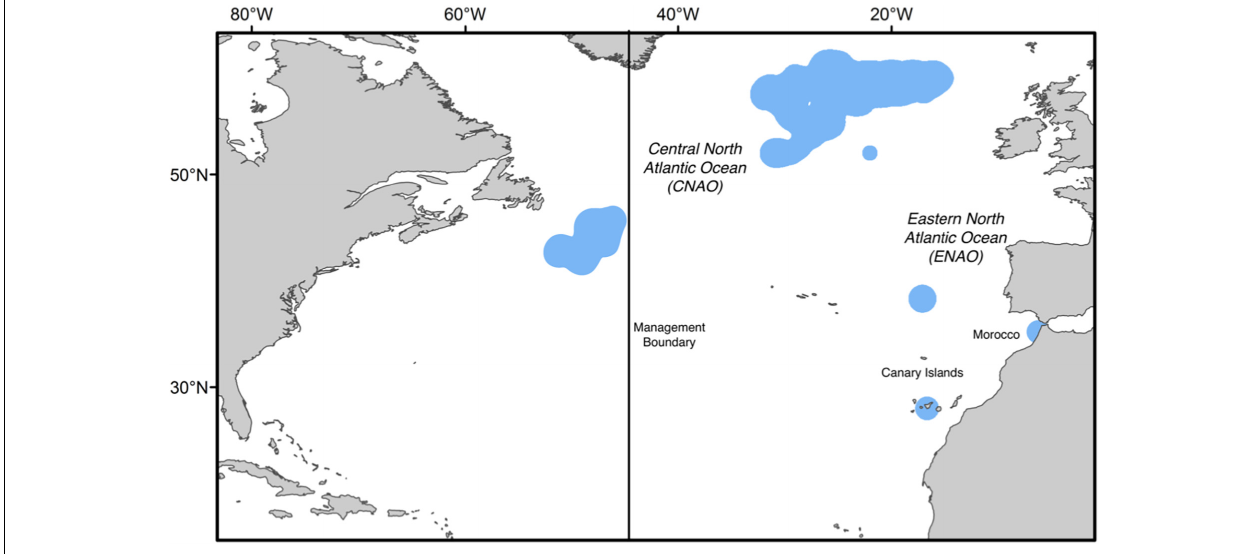
FIGURE 1 | Summary of the four sampling areas (blue shading) for Atlantic bluefin tuna ( Thunnus thynnus ). Collections included adult Atlantic bluefin tuna from both sides of the management boundary (45 ◦ W longitude) in the Central North Atlantic Ocean (CNAO) and two locations in the Eastern North Atlantic Ocean (ENAO): Morocco and Canary Islands. Sampling conducted from 2010 to